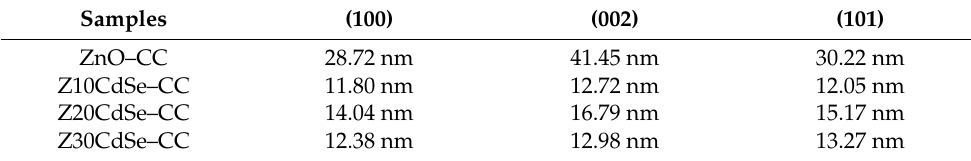
Table 1. Partial plane grain size (nm) of ZnO–CC, Z10CdSe–CC, Z20CdSe–CC, and Z30CdSe–CC.